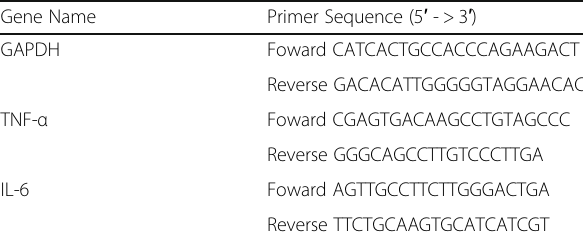
Table 1 Primer sequences used for qRT-PCR